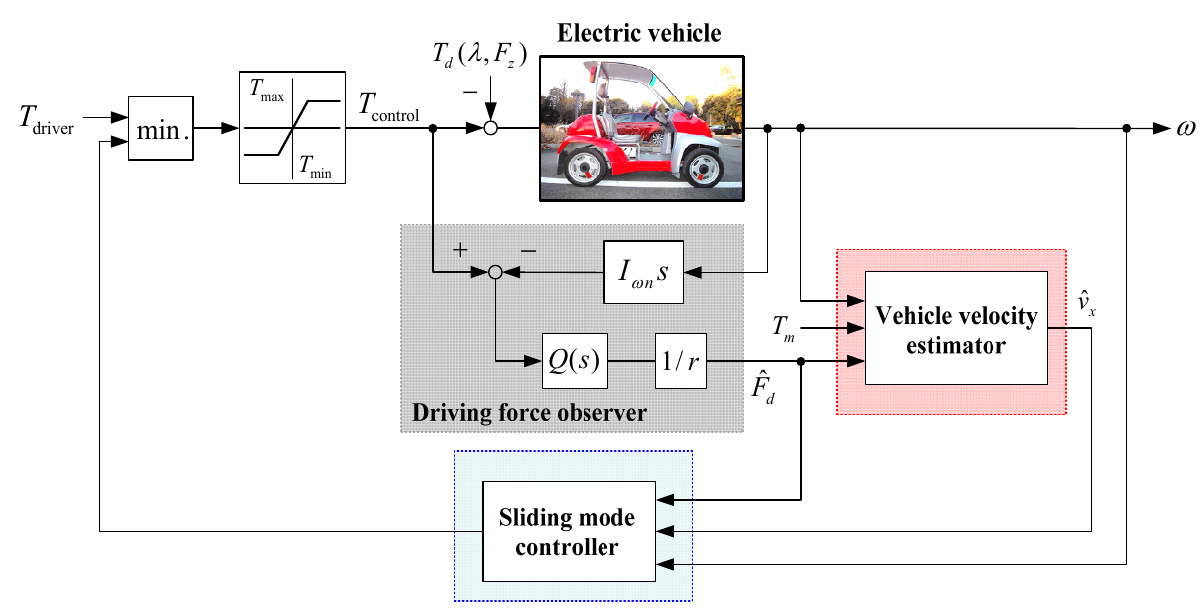
Figure 5. Overall structure of the proposed traction control